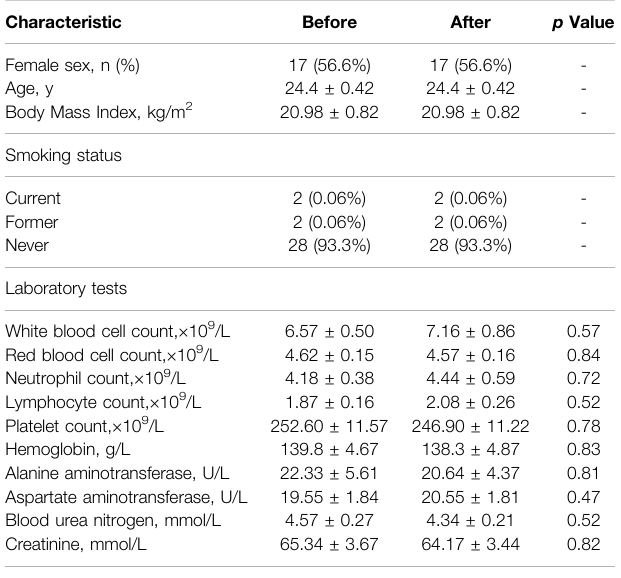
TABLE 1 | Characteristics and laboratory tests of the healthy volunteers. Characteristic